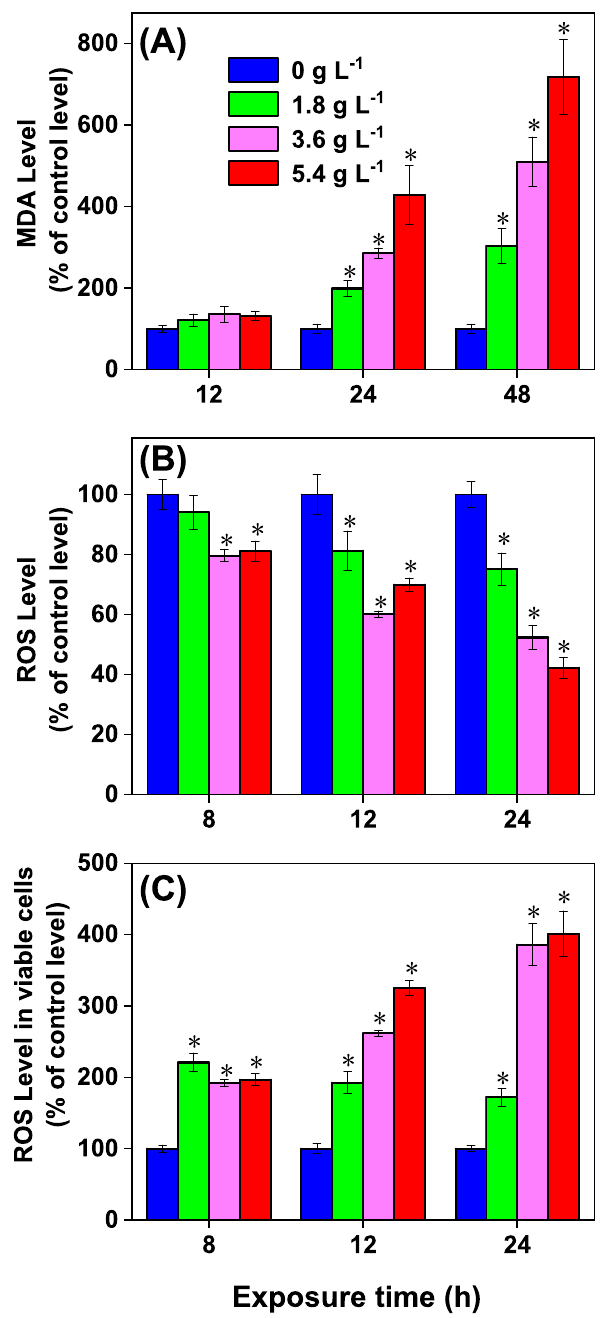
Figure 4. MDA level ( A ), ROS level ( B ), and ROS level in viable cells ( C ) of the Dolichospermum flos-aquae treated with aqueous extract of watermelon peel (WMPAE) at different concentrations. (Data are shown as mean ± standard deviation for n = 3, * indicates p <